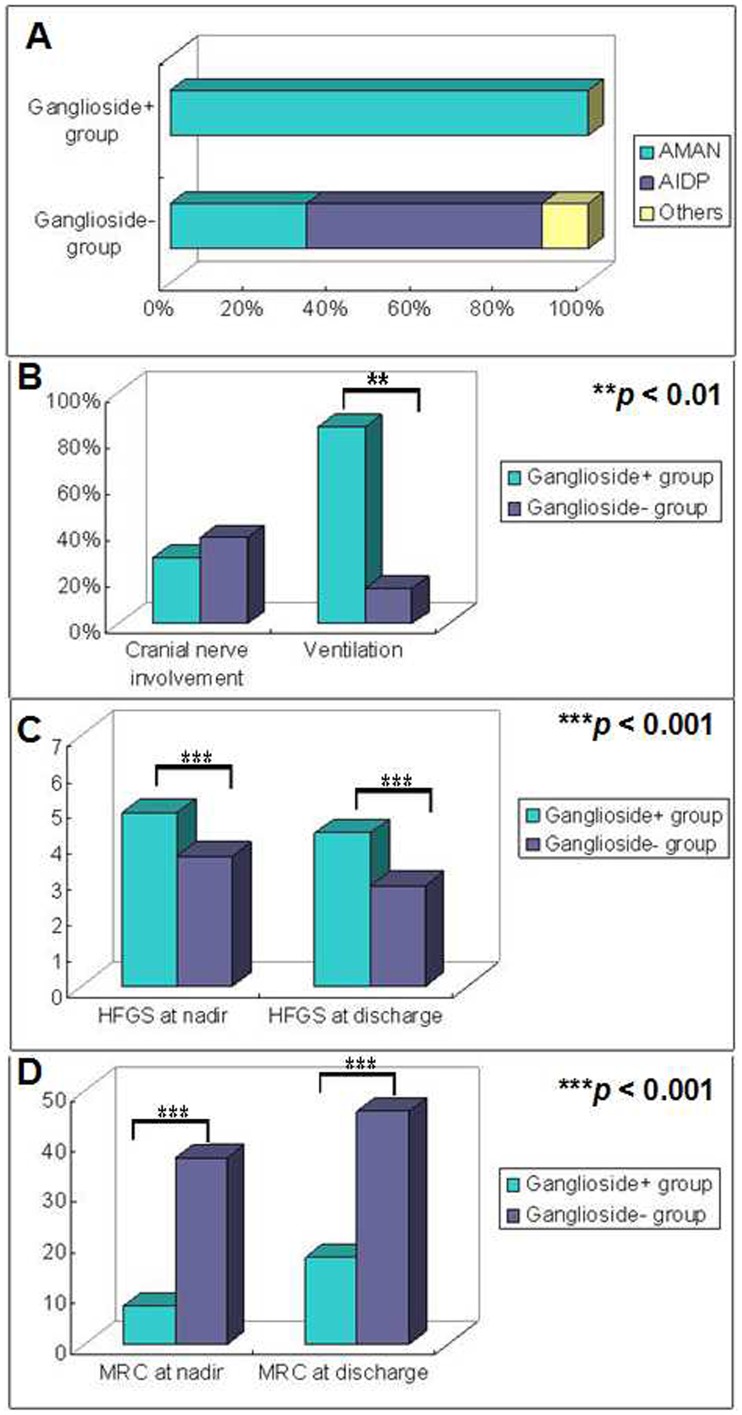
Comparisons of electrophysiological findings and functional deficits between the ganglioside+ and ganglioside− groups.
A. Electrophysiological examinations on patients in the ganglioside+ group revealed impairment mainly to axons suggestive of acute motor axonal neuropathy (AMAN). In the non-ganglioside-associated group (ganglioside− group), 46 out of 77 patients (59.7%) received electrophysiological examinations, and the ratios of acute inflammatory demyelinating polyneuropathy (AIDP) and AMAN were 56.5% and 32.6%, respectively. B. Two patients (28.6%) in the ganglioside+ group while 29 (37.7%) in the ganglioside− group were found with bilateral facial nerves palsy (p>0.05). The difference did not reach statistical significance. Ventilation ratio was significantly higher in the ganglioside+ group as compared that in the ganglioside− group (p<0.01). C. The scores of Hughes Functional Grading Scale (HFGS) were significantly different between the ganglioside+ group and the ganglioside− group, both at nadir and at discharge, and higher HFGS scores were found in the ganglioside+ group (p<0.001), suggestive of severe clinical course and poor short-term outcome. D. The Medical Research Council sum scores (MRC) were significantly lower in the ganglioside+ group both at nadir and at discharge (p<0.001).